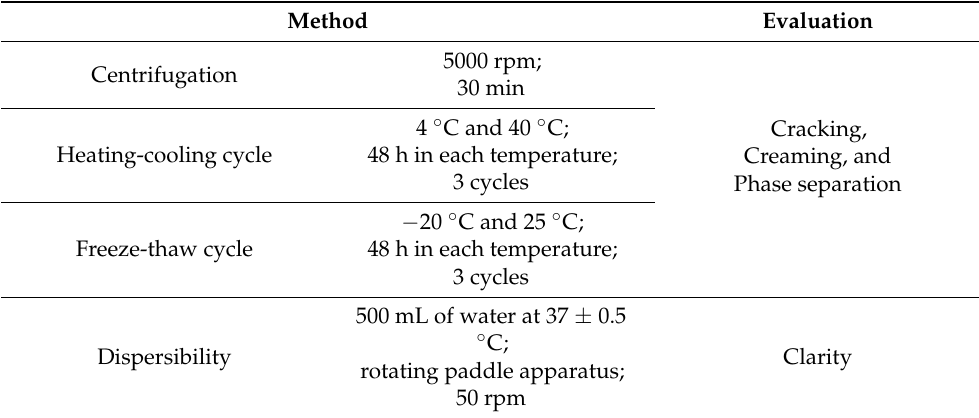
Table 2. Thermodynamic stability and dispersibility testing of ETB-NE and evaluation criteria. Method Evaluation